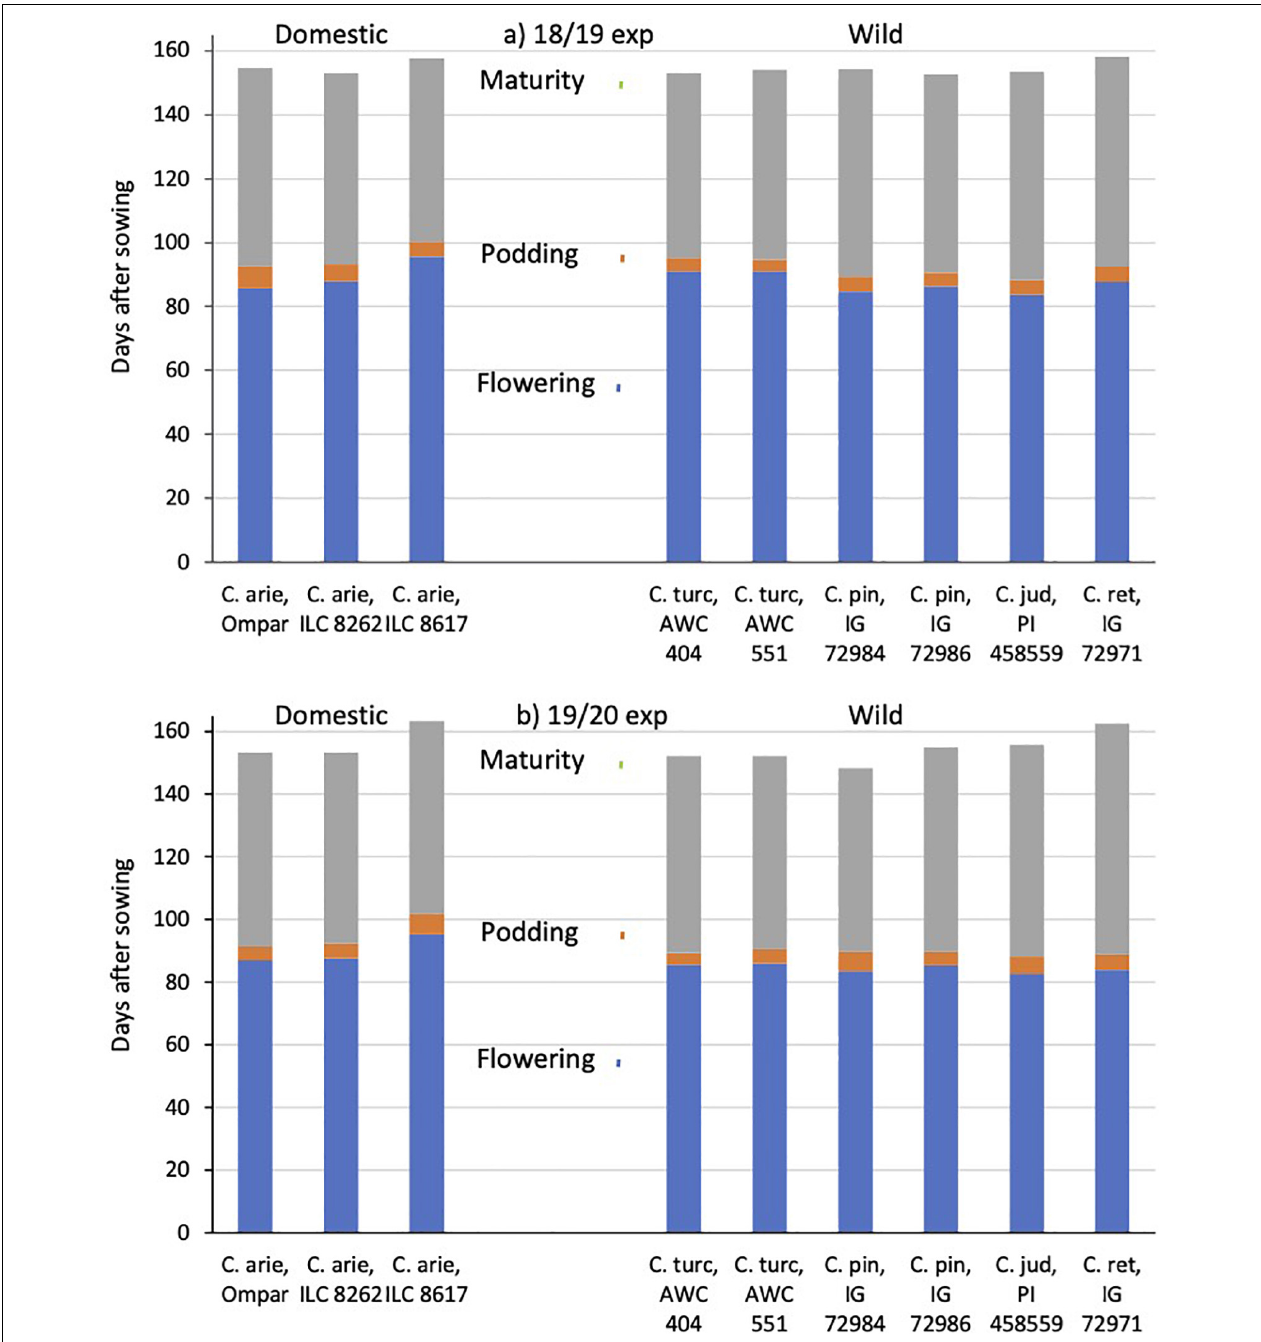
FIGURE 6 | C. turcicum phenology (flowering, podding, maturity) compared to related annual wild and domestic Cicer species. Data is from Mediterranean cool-season common garden screenhouse comparisons at Akdeniz University, (a) 2018/19, (b) 2019/20. Color-coded vertical lines represent accession least significant differences (LSD P < 0.05) for flowering (2.6–2.7 days), podding (2.4–2.7 days) and maturity (1.9–2.4 days). Abbreviations: C. arie, C. arietinum ; C. turc, C. turcicum ; C. pin, C. pinnatifidum ; C. jud, C. judaicum ; C. ret, C. reticulatum